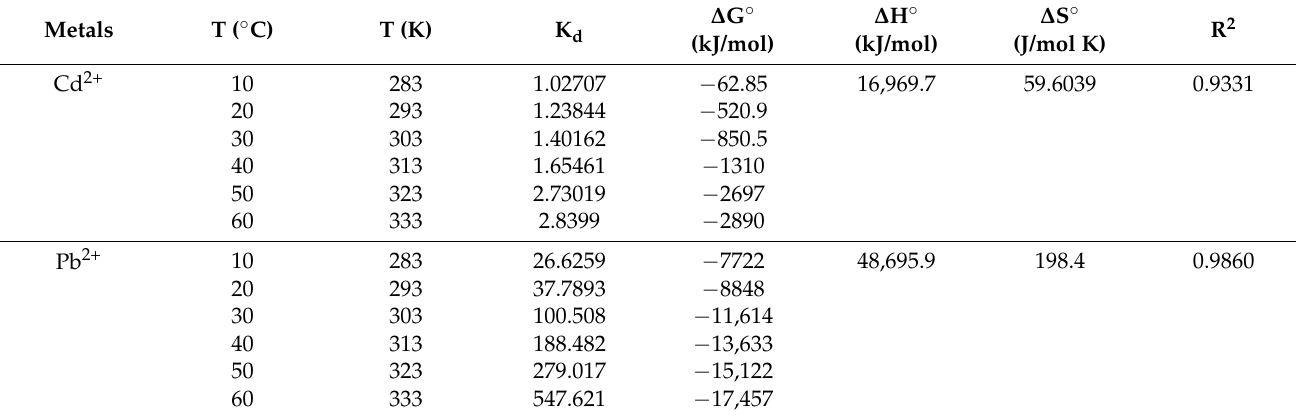
Table 6. Thermodynamic parameters of Cd 2+ and Pb 2+ adsorption onto